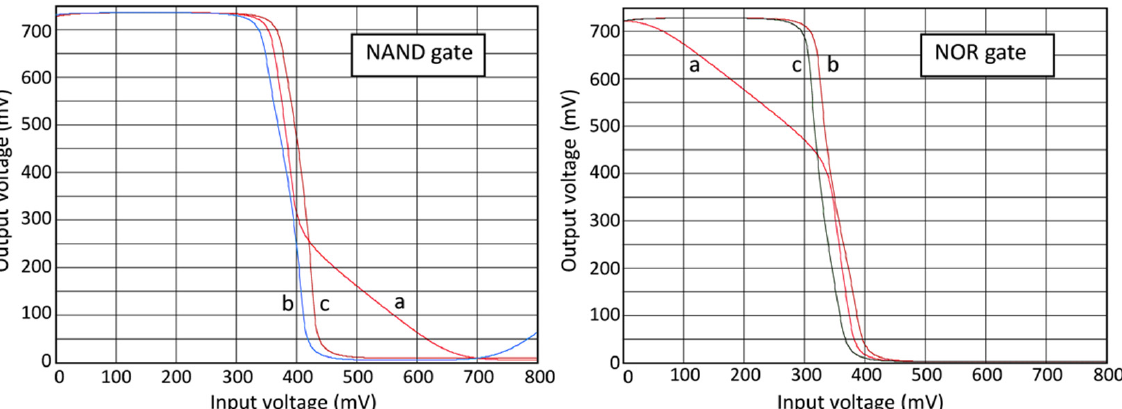
Figure 13. Transfer characteristics of NAND and NOR gates. V CC = 1 V, R = 500 k Ω , temperature 300